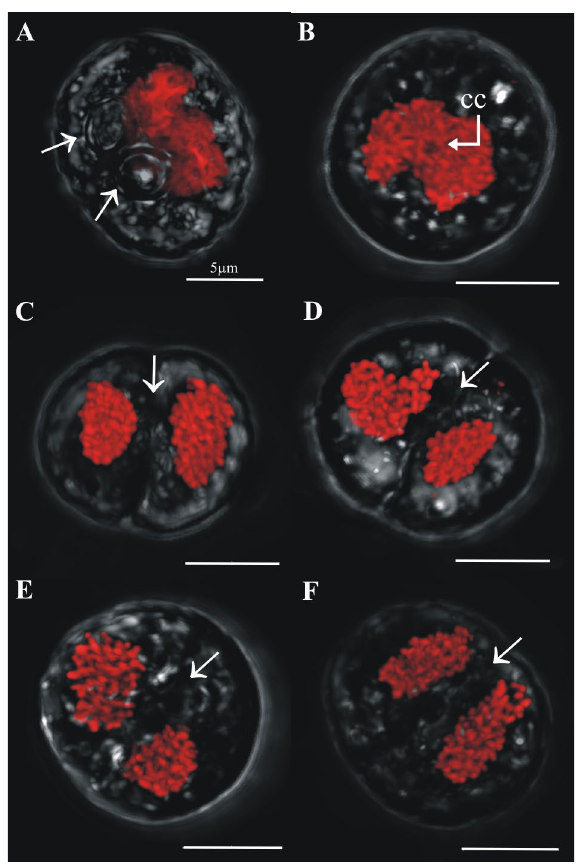
Figure 7. Confocal images of cells sorted in the (> 2C–4C) DNA content gate that have one nucleus or two nuclei. Chromatin was less condensed in these cells, in which two pyrenoids were detected ( A , arrows). A central cytoplasmic channel (cc, bent arrow) was observed in one of these cells ( B ). Cells with two nuclei (dyads) were considered meiotic and are distinct from two nuclei mitotic cells due to their higher DNA content and the different morphology and shape displayed between both nuclei ( C – F ). Dividing furrows in dyads are indicated by an